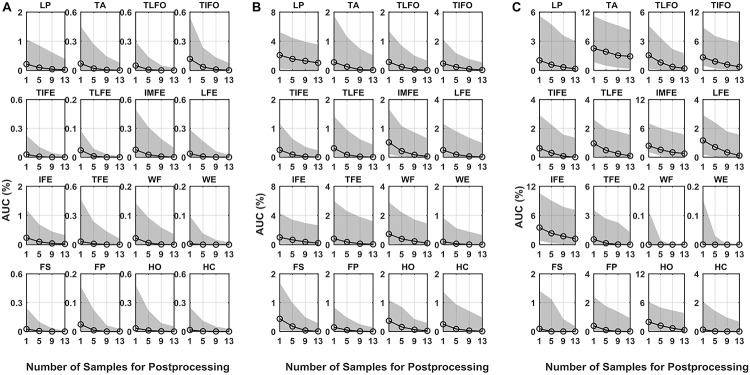
AUC of DET for the 16 gestures, LP, TA, TLFO, TIFO, TIFE, TLFE, IMFE, LFE, IFE, TFE, WF, WE, FS, FP, HO, and HC, in three scenarios: (A) normal test, (B) leaked test, and (C) self-test. The dot in each plot represents the median value of AUC, and the shaded area represents the range between the first quantile to the third quantile. The scales are different in each plot.